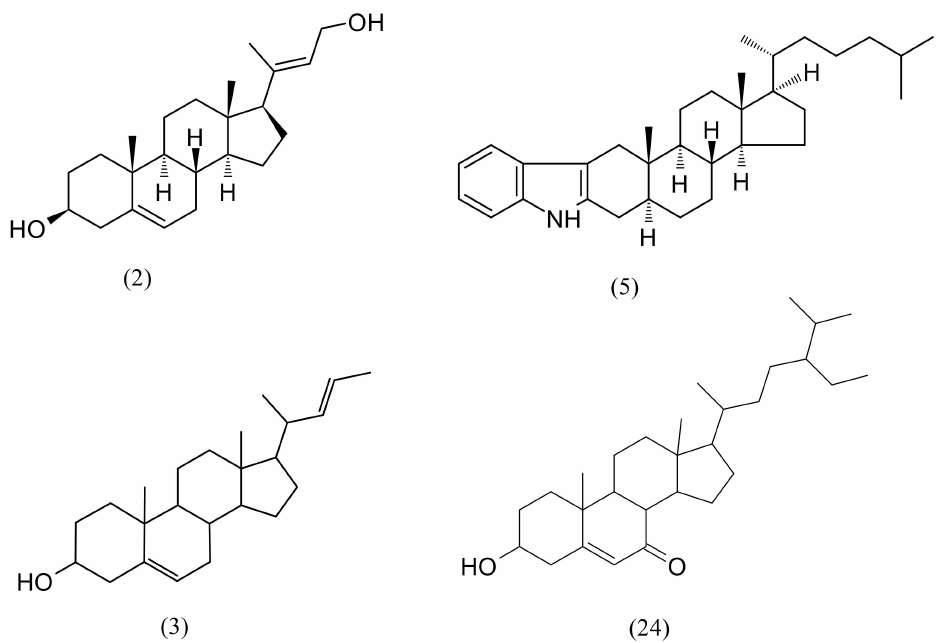
Figure 5. Molecular structures of the major compounds of steroids from Table 3, and the numbers correspond to Table